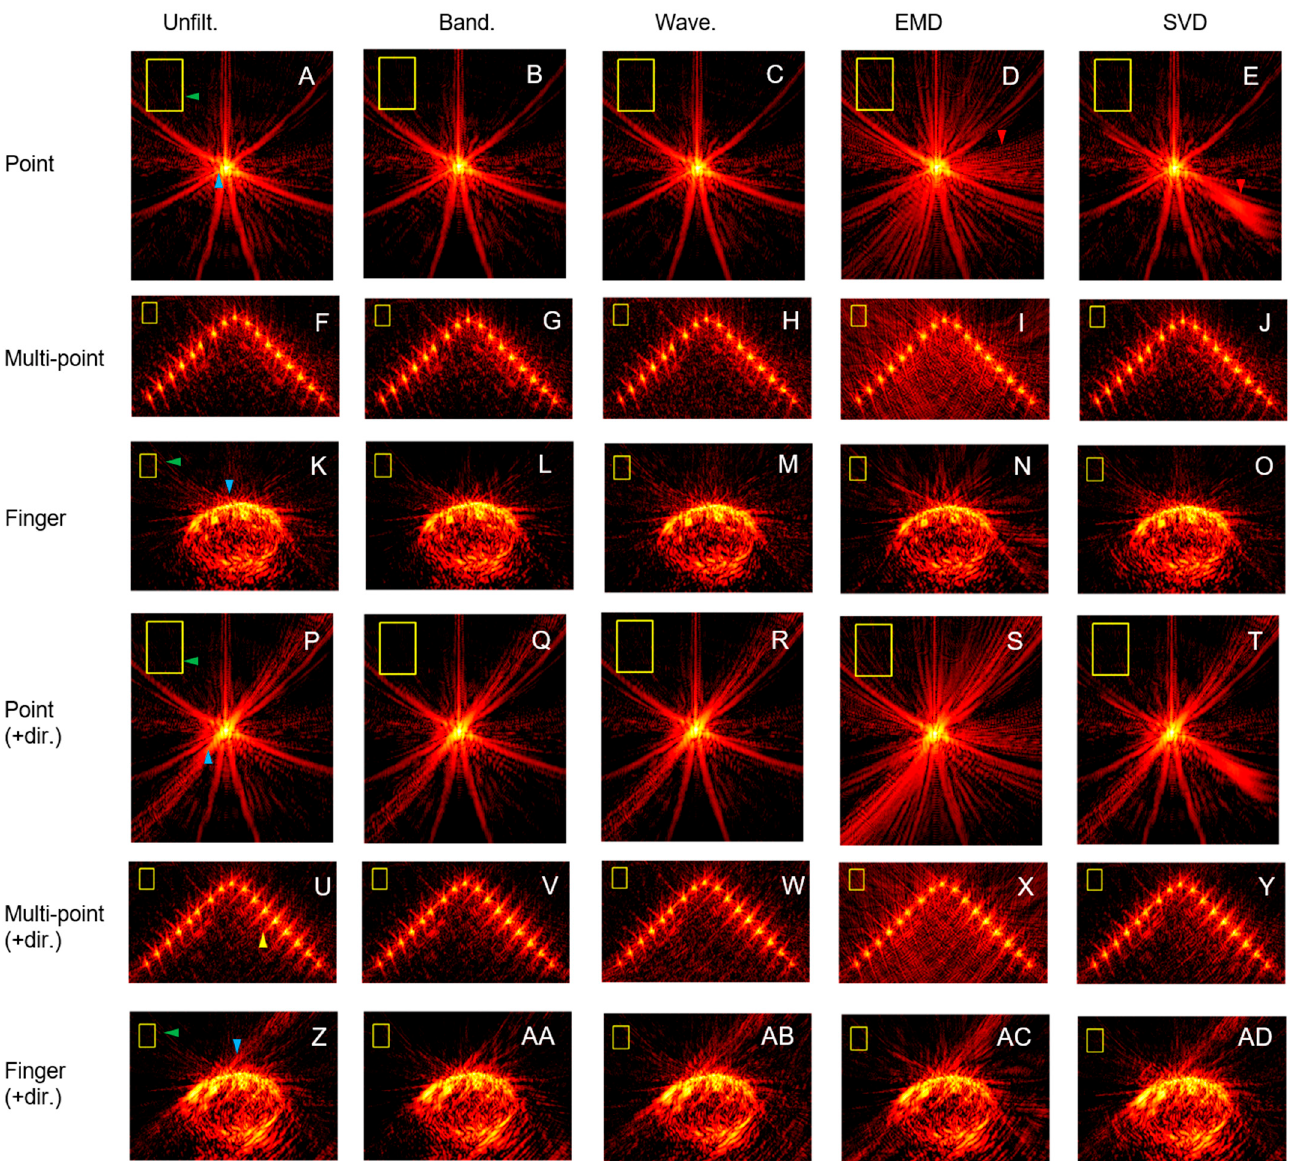
Figure 3. Whole images shown on the log scale widened to show the noise for all methods for the point, multi-point, and finger acquisitions without directivity (first three rows) and with directivity (last three rows). Noise ROIs were annotated as yellow boxes. The dynamic range was 50 dB for point acquisition, 40 dB for multi-point acquisition, and 35 dB for finger acquisition. The markers show the points of comparison mentioned in the discussion.